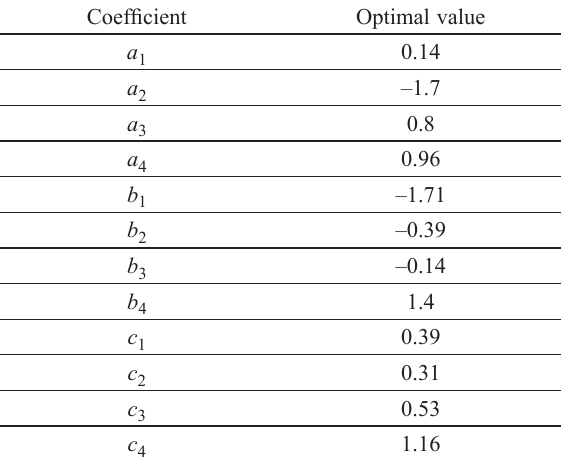
Table 3. The optimal values of the coefficients Coefficient